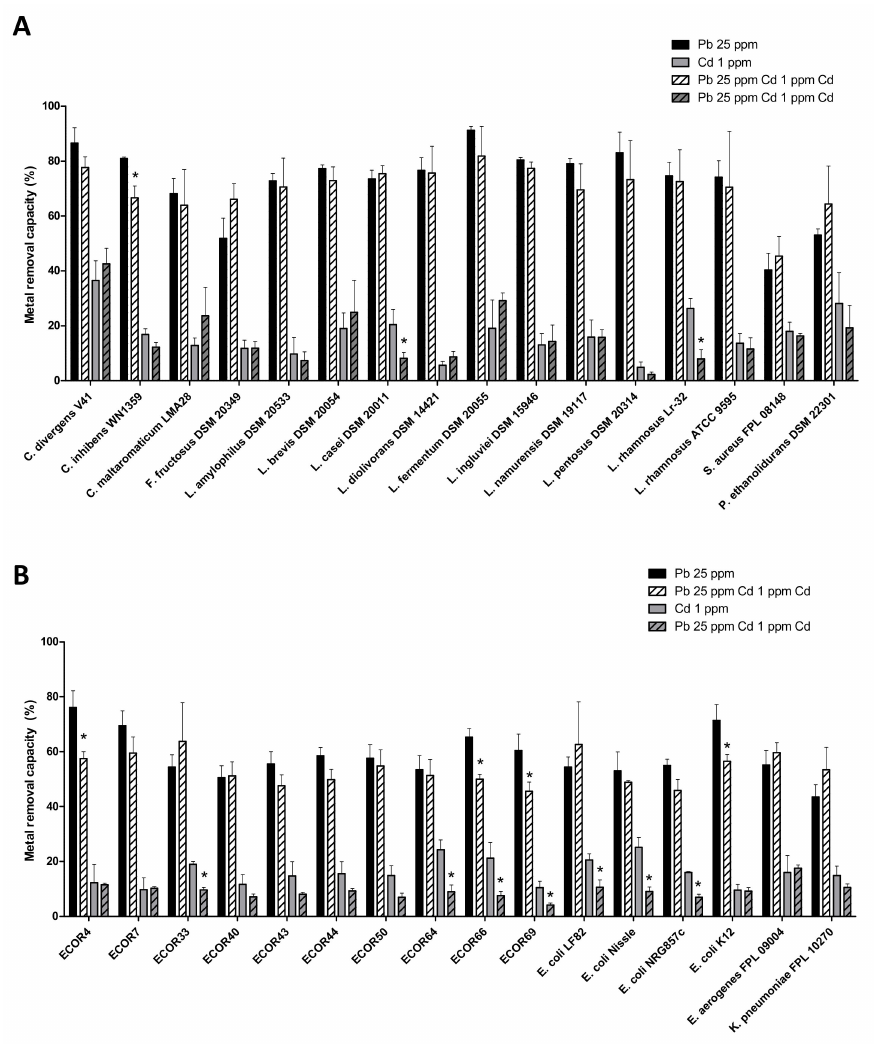
Figure 5. Pb removal capacities for 25 ppm Pb alone (black) or with 1 ppm Cd (hatched black) and Cd removal capacities for 1 ppm Cd alone (in grey) or with 25 ppm Pb (hatched grey). Panel ( A ): Lactic acid bacteria and other Gram positive bacteria. Panel ( B ): Enterobacterales. Metal removal capacity was defined as the mean ± SD percentage of the initial quantity of metal in solution, in triplicate experiments. * indicates a statistically significant ( p < 0.05) difference between the metal alone and the metal in a